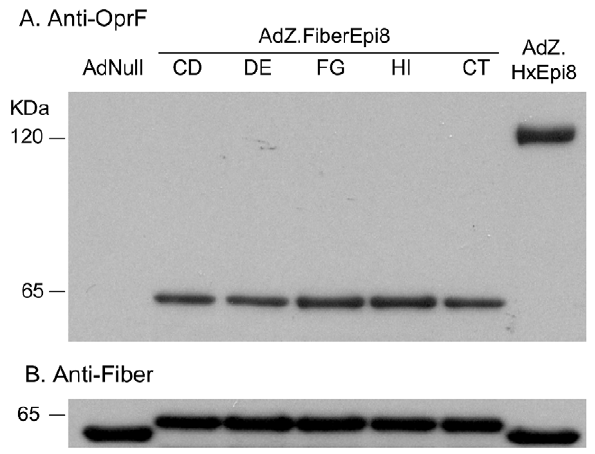
Figure 2. P.aeruginosa Epi8 epitope in various Ad vector fiber sites. The fiber-modified Ad vectors AdZ.F(CD)Epi8, AdZ.F(DE)Epi8, AdZ.F(FG)Epi8, AdZ.F(HI)Epi8 and AdZ.F(CT)Epi8, the hexon-modified AdZ.HxEpi8 or AdNull as control (all 10 10 particles) were separated on 4–12% polyacrylamide gradient SDS-PAGE, transferred to a polyvinyli- dine difluoride membrane and evaluated by Western blot analysis using